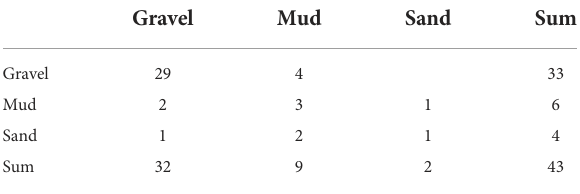
TABLE 6 Contingency table of the random forest.